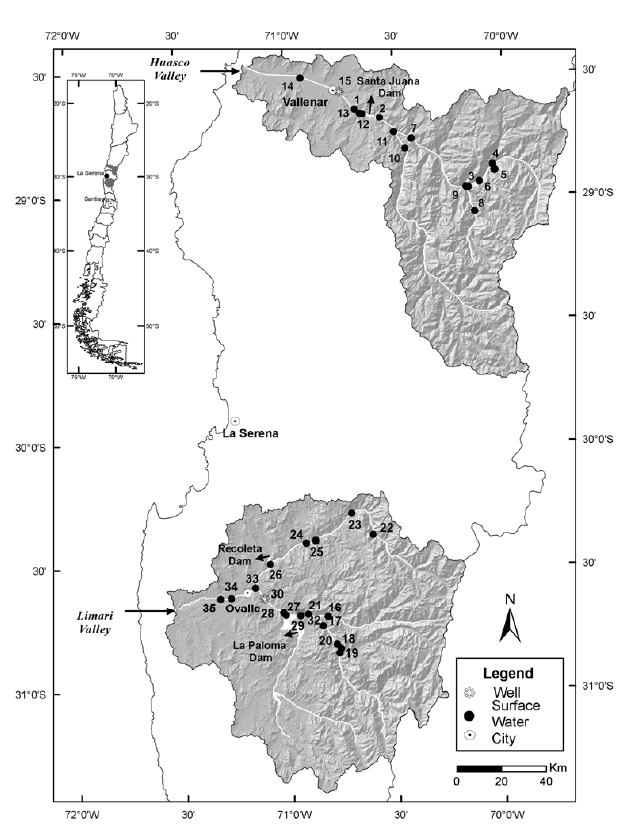
Fig. 1. Investigation areas and sampling locations in the catchments Figure 1 of Rio Huasco (above) and Rio Limar´ı Investigation areas and sampling locations in the catchments of Rio Huasco (above) and Rio Limarí (below)